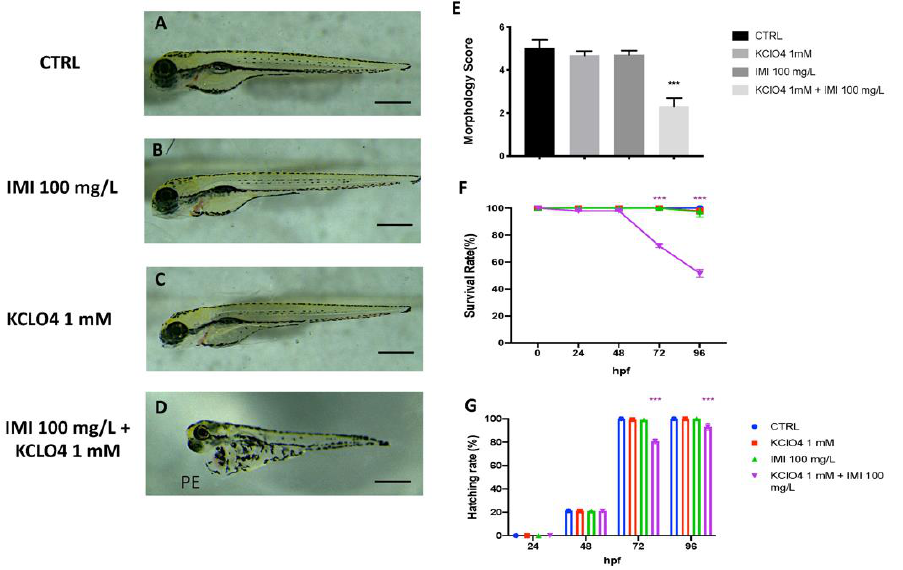
Figure 3. Effects of KClO 4 and Cd single and co-exposure on morphological changes in zebrafish larvae at 96 hpf. CTRL ( A ). KClO4 ( B ). Cd ( C ). KClO 4 +Cd ( D ). Morphology score ( E ). Survival rate and ( F ) hatching rate ( G ) of zebrafish larvae treated. PE—pericardial edema. *** p < 0.001 versus